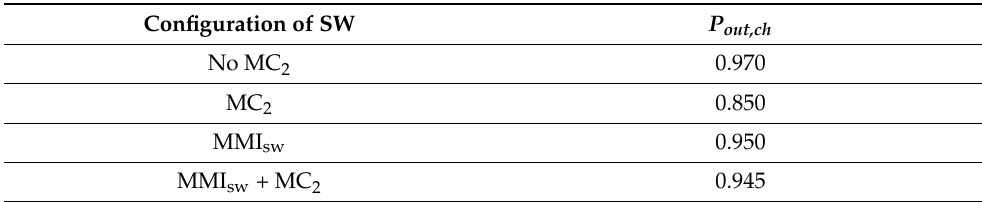
Table 2. Transmitted power from the SW in all the explored cases.